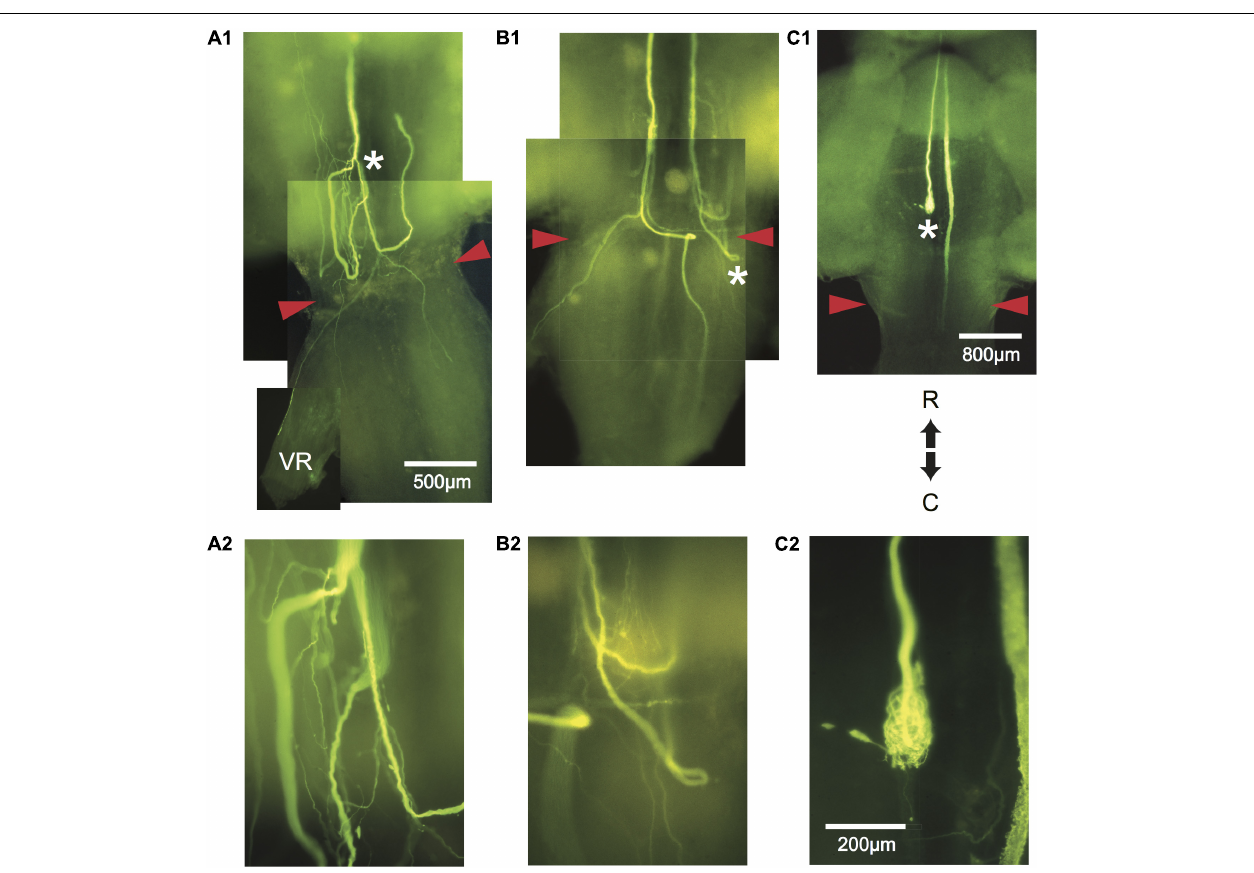
FIGURE 4 | Aberrant pathway choice of axotomized M-axons. (A1) Sprouting of the left M-axon of a fish 66 days postoperatively. The photographic montage of brain wholemounts shows reversal of direction (from caudal to rostral) of a number of sprouts anterior to the level of the wound site (marked by red arrowheads in this and subsequent panels), a midline crossing from left to right, a sprout that projects out the left ventral root (VR), and sprouts that project caudally past the wound site. The area to the left of the asterisk of panel (A1) is enlarged in panel (A2) . (B1) Montage illustrating regrowth of both M-axons in a fish 63 days postoperatively. The right axon has at least two sprouts that reverse direction (caudal to rostral) rostral to the wound and one that reverses within the wound. The left axon crosses the midline within the wound and projects caudally and laterally. A sprout on the left side projects out the ventral root. The area above the asterisk in panel (B1) is enlarged in panel (B2) . (C1) The left M-axon of a fish 78 days postoperatively appears to have no regrowth. However, in the higher magnification of panel (C2) , it is clear that the axon has formed a neuroma. Only the sheath of the right axon has been filled with dye. R, rostral; C, caudal. All photographs are from brain wholemounts rostrally toward the top and caudally toward the